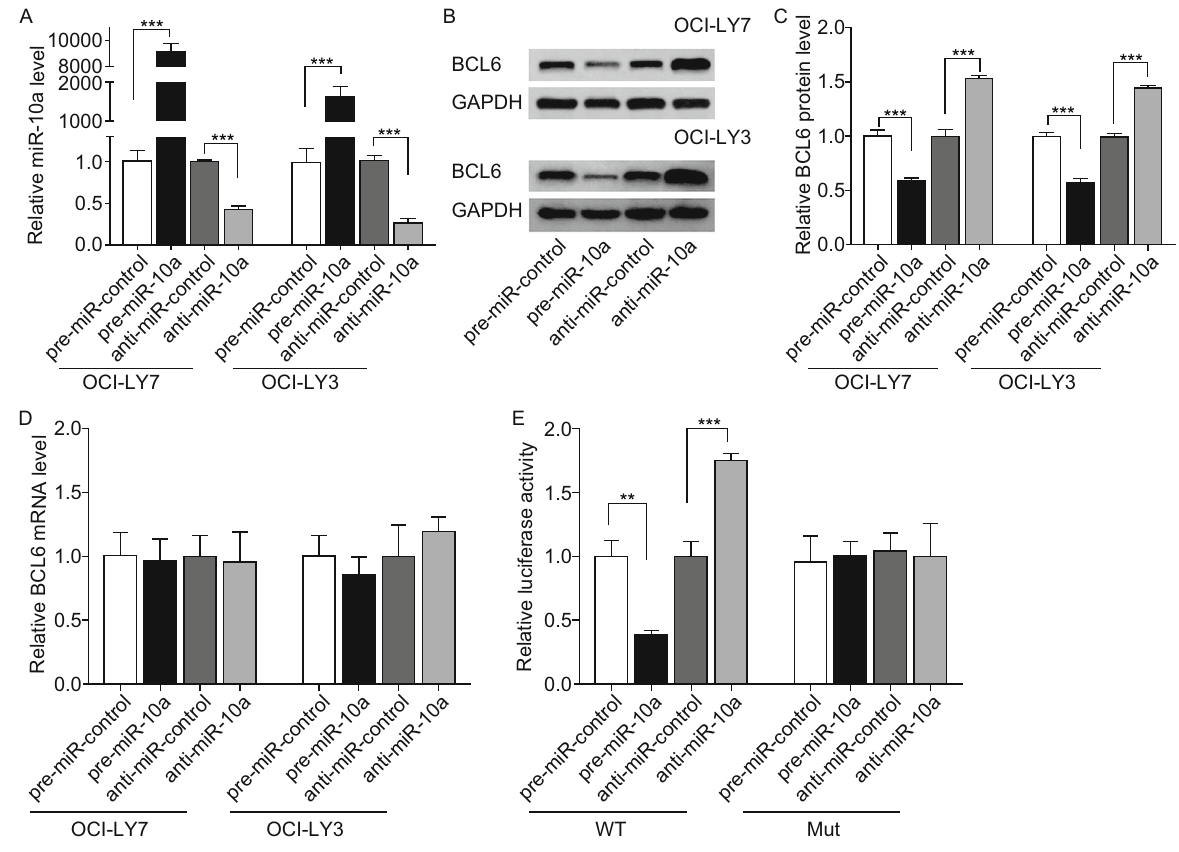
Figure 3. Direct regulation of BCL6 expression by miR-10a at the posttranscriptional level. (A) Quantitative RT-PCR analysis of miR-10a levels in OCI-LY7 and OCI-LY3 cells treated with pre-miR-control, pre-miR-10a, anti-miR-control or anti-miR-10a. U6 snRNA was used as an internal control, and the relative amount of miRNA normalized to the U6 snRNA levels was calculated using the 2 - ΔΔ CT formula, in which ΔΔ C T = (C T miRNA - C T U6 ) target - (C T miRNA - C T U6 ) control . (B and C) Western blot analysis of BCL6 protein levels in OCI-LY7 and OCI-LY3 cells treated with pre-miR-control, pre-miR-10a, anti-miR-control or anti-miR-10a. B: